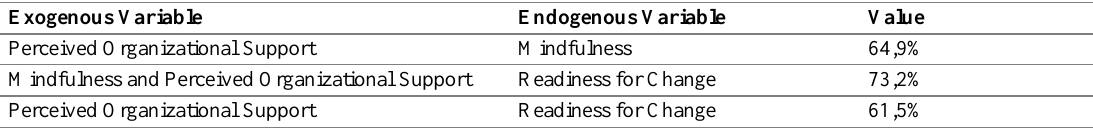
Table 7: Results of Determinant